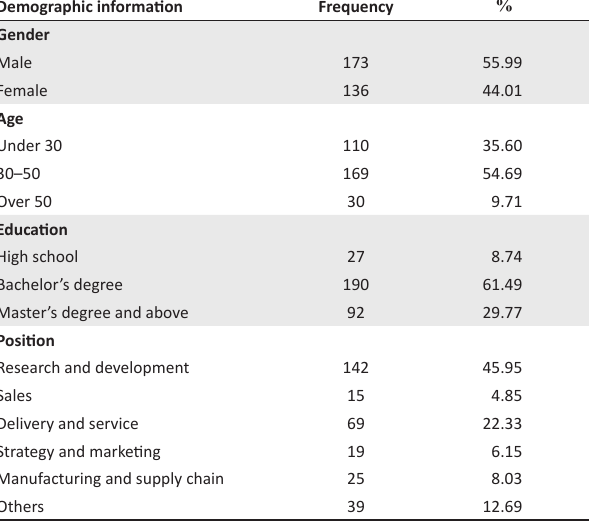
TABLE 2: Respondent’s profile ( n = 309). Demographic